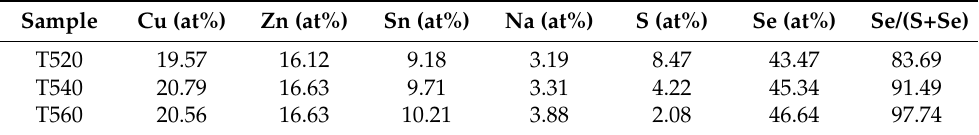
Table 1. EDS results of the Na-doped Cu 2 ZnSn(S,Se) 4 films selenized at different temperatures ranging from 520 to 560 ◦